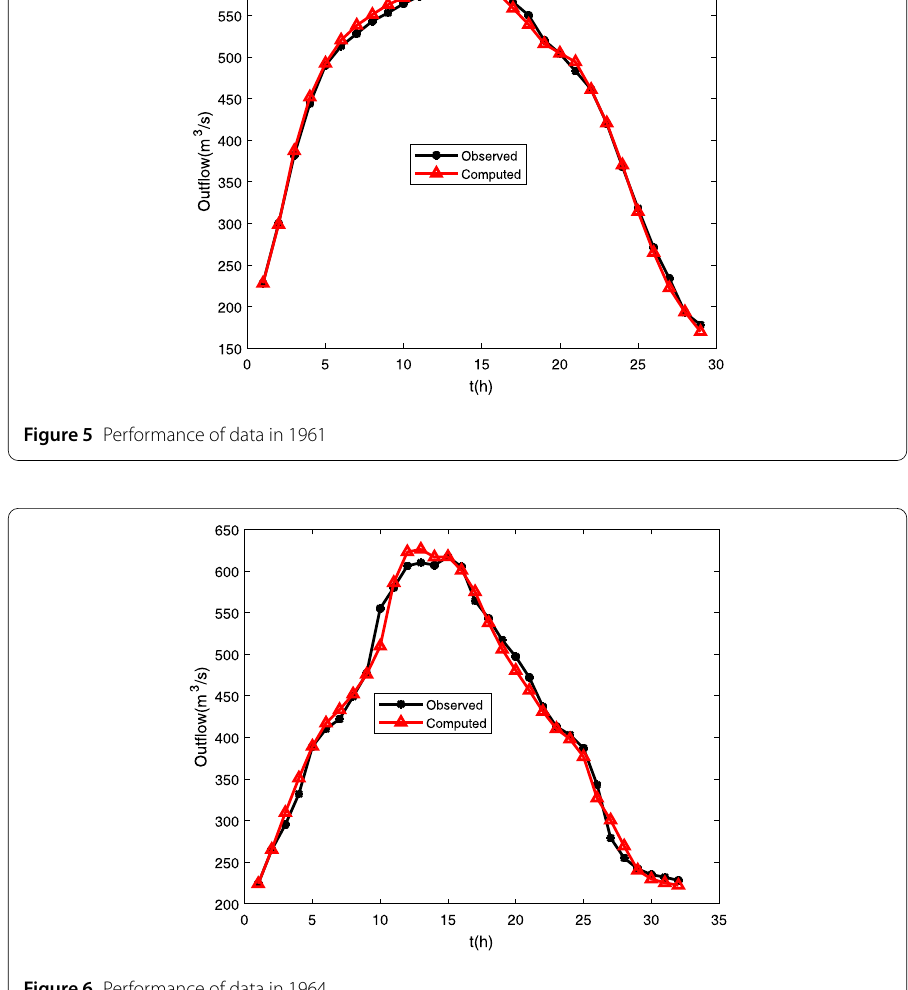
Figure 6 Performance of data in